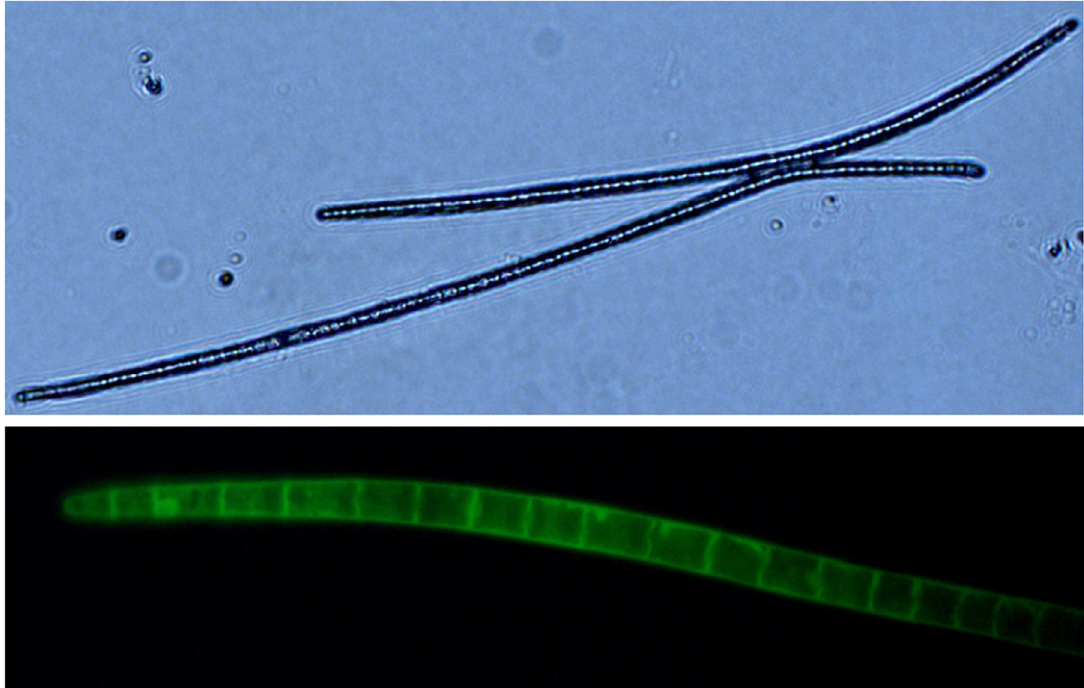
Fig 3. Microscopy images of fully ejected ascospores of C . sinensis without staining (upper panel; 40x) or after staining with 0.01% calmodulin for visualization of the septa of multicellular ascospores (lower panel; 400x).